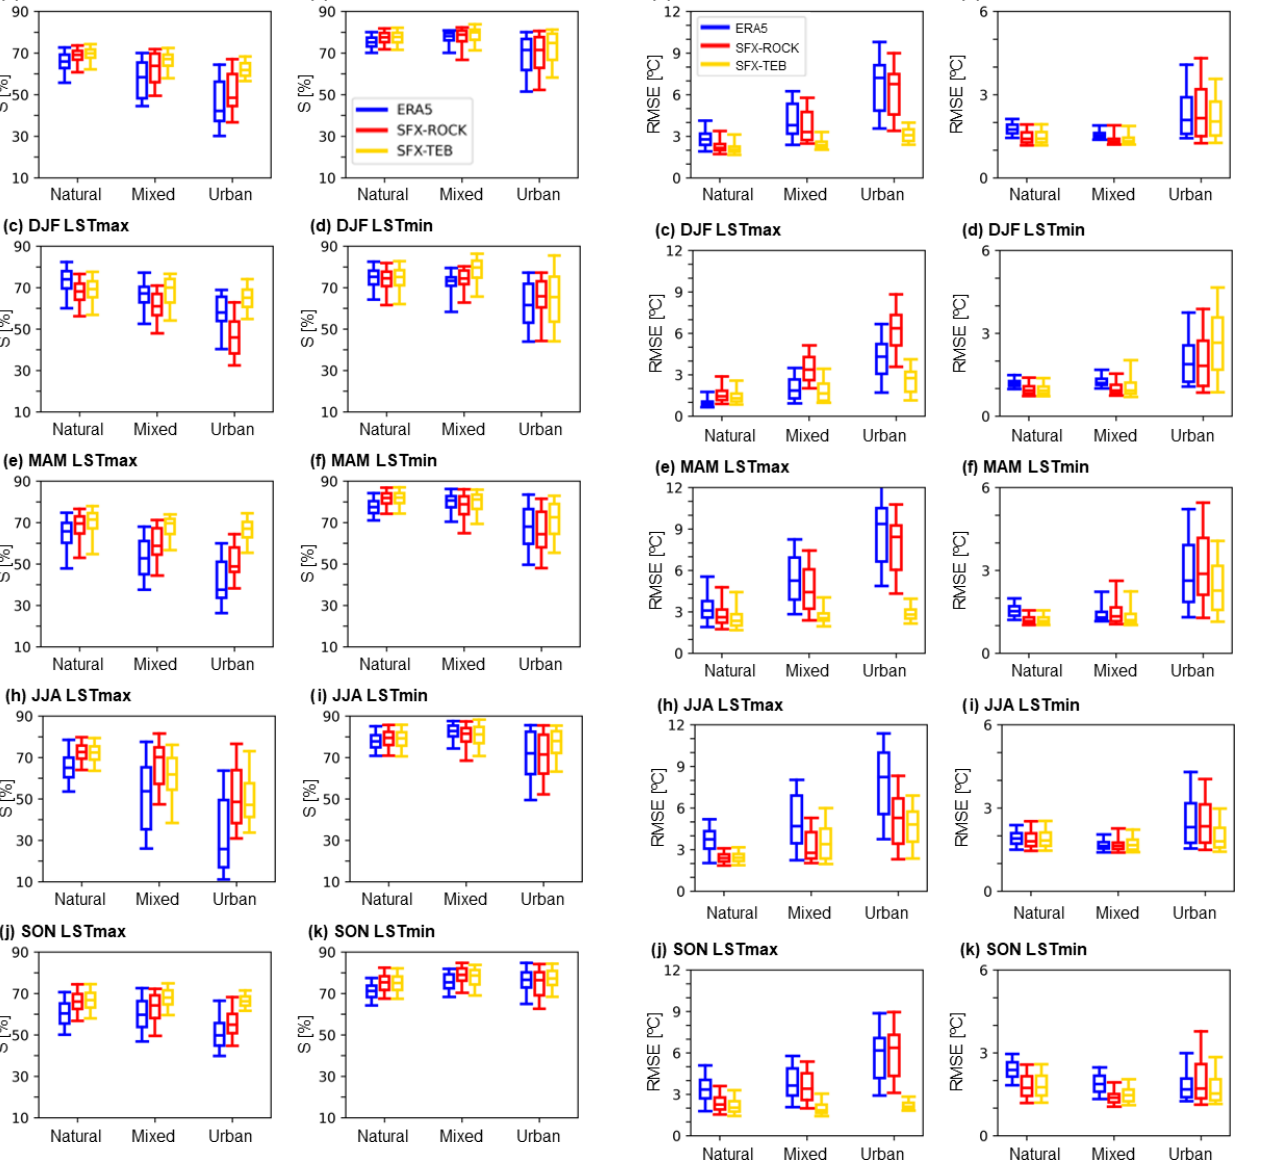
Figure 5. Box plots of the S score computed over the 2004–2018 period from ERA5 (blue), SFX-ROCK (red), and SFX-TEB (yel- low) for natural surfaces (grid boxes with urban fraction below 0.33), mixed surfaces (grid boxes with urban fraction between 0.33 and 0.66), and urban surfaces (grid boxes with urban fractions above 0.66). From top to bottom, the rows represent the S score computed for the full annual cycle, i.e., DJF, MAM, JJA, and SON. pared to the SUHI was likely related to the ability of the model to represent part of the nighttime urban canopy layer heating associated with prescribed anthropogenic heat fluxes, while the lack of land–atmosphere feedbacks inhibits this warmer canopy layer from affecting the LST.